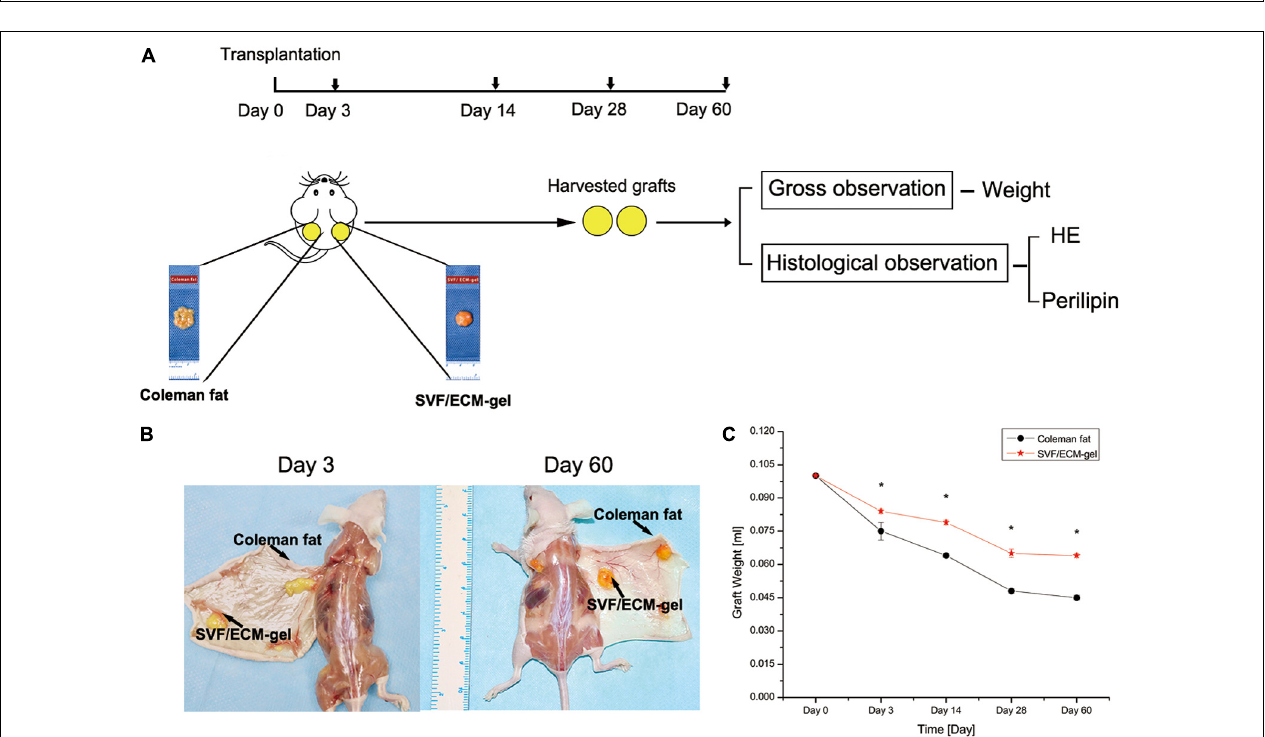
FIGURE 1 | Preparation process of SVF/ECM gel and Coleman fat. Coleman fat was obtained using centrifugation of fat aspirates. The upper oil and fat layers were retained by removing the lower water layer, and the mixture was pushed to form the enmeshed fat. After centrifugation, the SVF/ECM gel was obtained. The whole preparation involves pure physical action, without the use of any foreign additives.